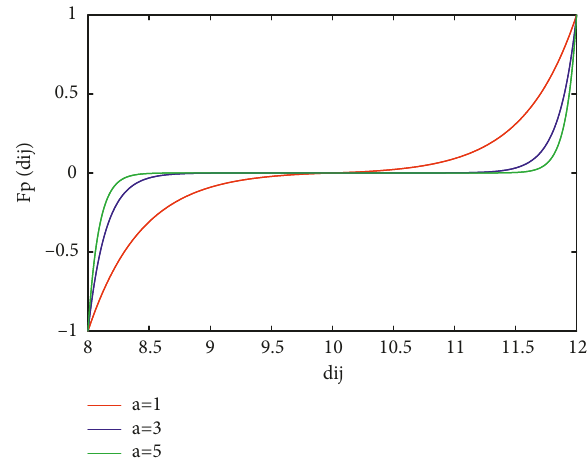
Figure 1: The plot of the force F ( d ) generated by the artificial p ij potential field with respect to actual distance. When the actual distance is greater than the desired distance, F p ( d ij ) is positive, which makes the train accelerate. Otherwise, the train slows down. And, the parameter a affects the stable range of